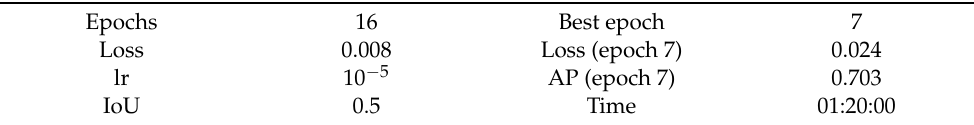
Table 3. Training parameters and results.